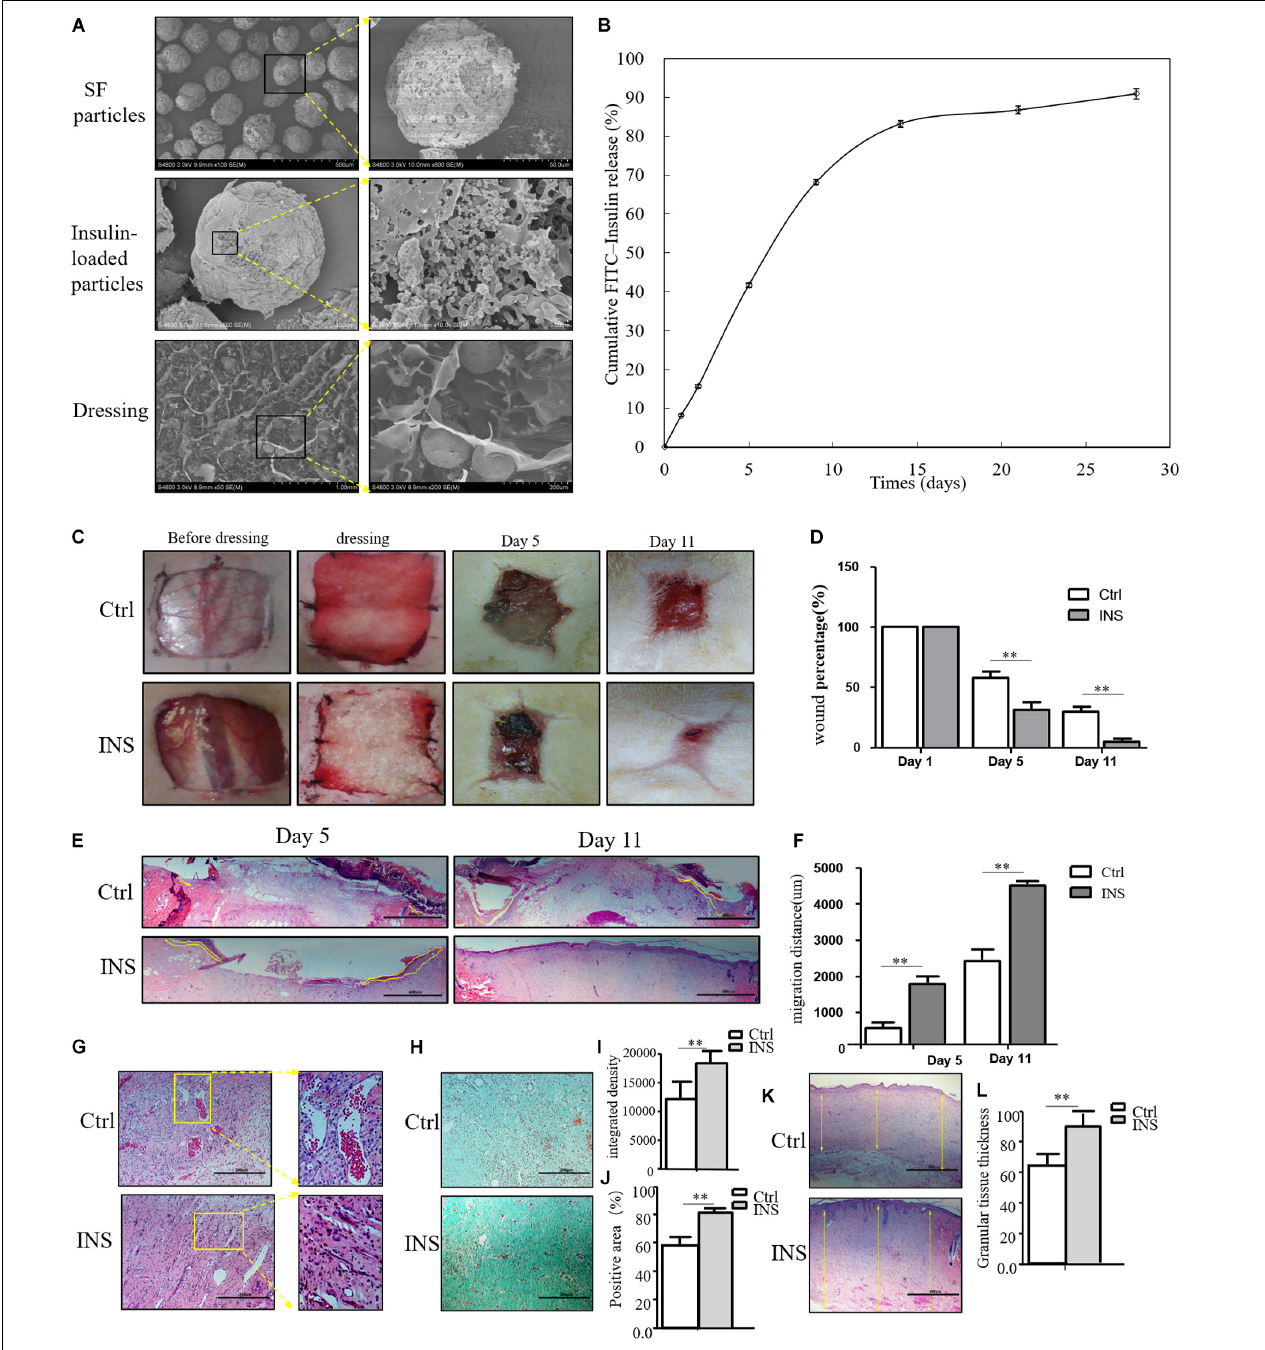
FIGURE 2 | Insulin-containing SF microparticles promote diabetic wound healing. (A) The SEM and cross-sectional views of SF microparticles, insulin-encapsulated SF microparticles, and microparticle-loaded SF. (B) Cumulative FITC–insulin release from microparticle-loaded SF dressings. (C,D) Insulin promoted healing of diabetic wound. After the wounding procedure, the wounds in the control group (Ctrl) were dressed with SF microparticles without insulin; wounds were dressed with the insulin-containing SF microparticles in the insulin group (INS). Wound sizes were recorded on the 1st, 5th, and 11th days after wounding using transparent tracing papers. The unhealed rate of wounds was calculated by Image Pro Plus. Data are shown as mean ± SD. ** p < 0.01, n = 5. (E,F) Insulin-containing dressing enhances reepithelialization of diabetic wounds. Reepithelialization was analyzed on the 5th and 11th day of wounding. The migration length of the tongue was calculated by Image Pro Plus. Data are shown as mean ± SD. ** p < 0.01, n = 5. (G) Insulin-containing dressing alleviates aberrant angiogenesis of diabetic wounds. Angiogenesis quality of the 5th-day wounds was evaluated by H&E observation. (H–J) Insulin-containing dressing promotes collagen deposition of diabetic wounds. Masson trichrome staining was used to check collagen deposition in the wound. The integrated density and positive area of collagen deposition were calculated, and data are shown as mean ± SD. ** p < 0.01, n = 5. (K,L) The thickness of the granular tissue was used as a marker of ECM deposition. Data are shown as mean ± SD. ** p < 0.01, n =